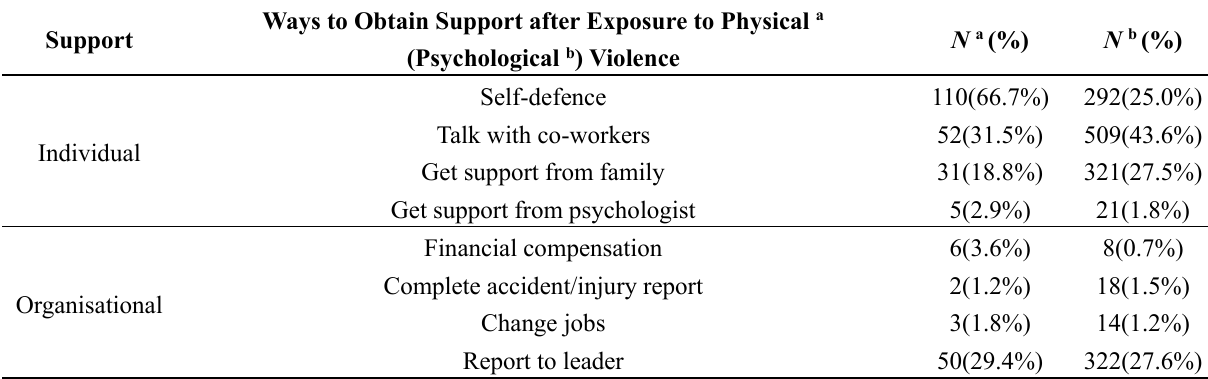
Table 2. Methods of obtaining support after exposure to